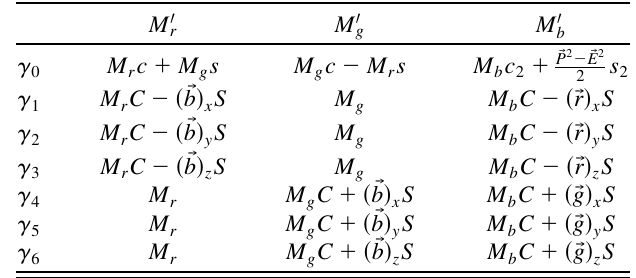
TABLE I. Table of transformed mass components for sym- plectic transformations in two dimensions. Compare Eqs. (31), (32), and